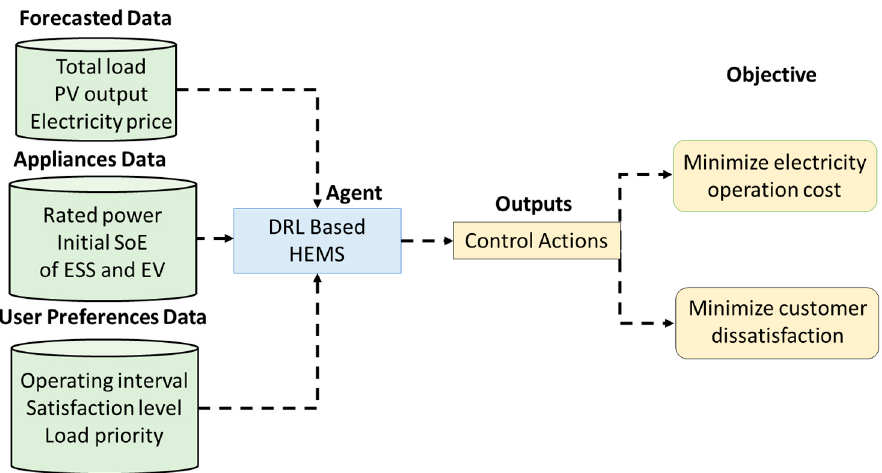
Figure 4. DRL-HEMS structure .